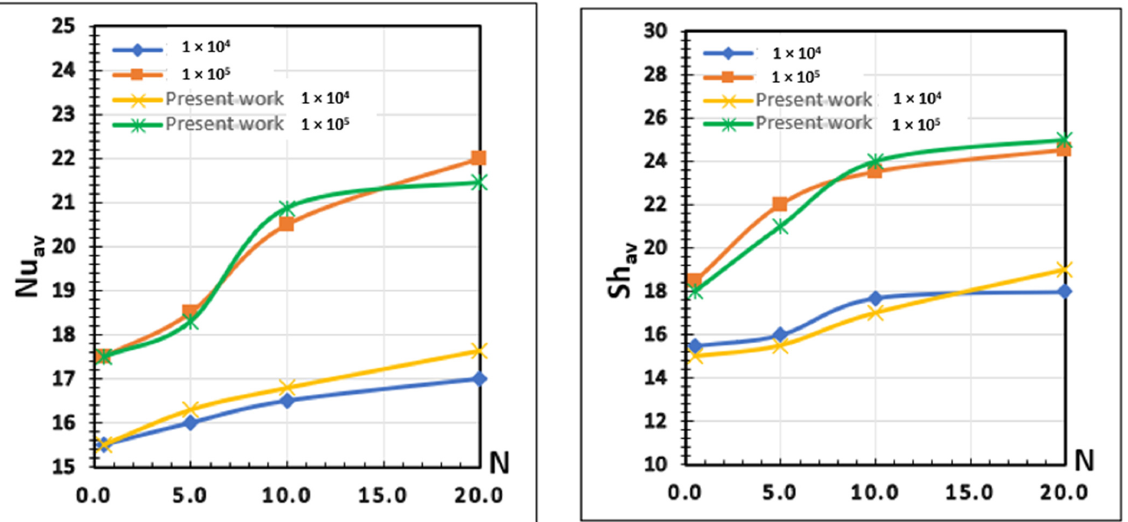
Figure 3. Comparison between the results of the average Nusselt and Sherwood numbers in the current study with the results of Rahman et al. [24].